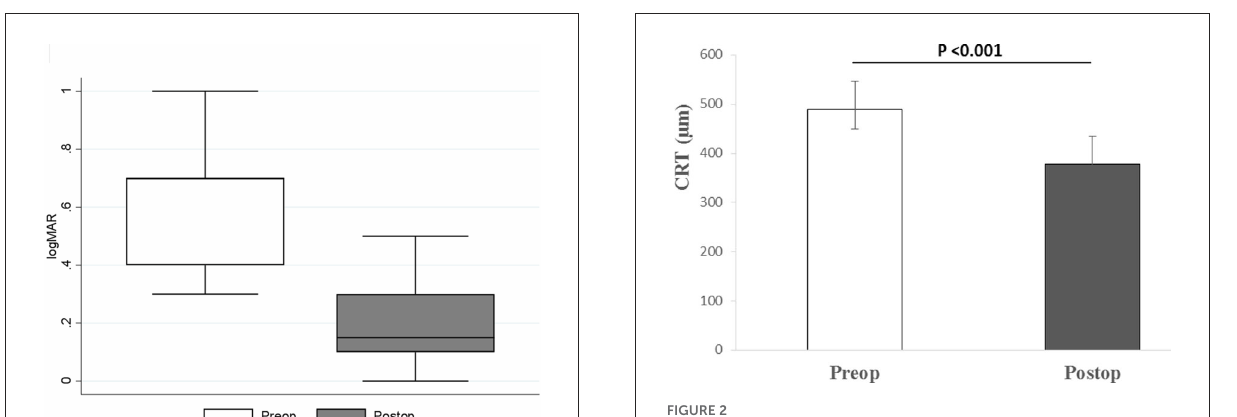
FIGURE2 Median (IQR and range) of pre- and post-operative central retinal thickness. Preop., pre-operative; Postop., post-operative; CRT, central retinal thickness; µ m,